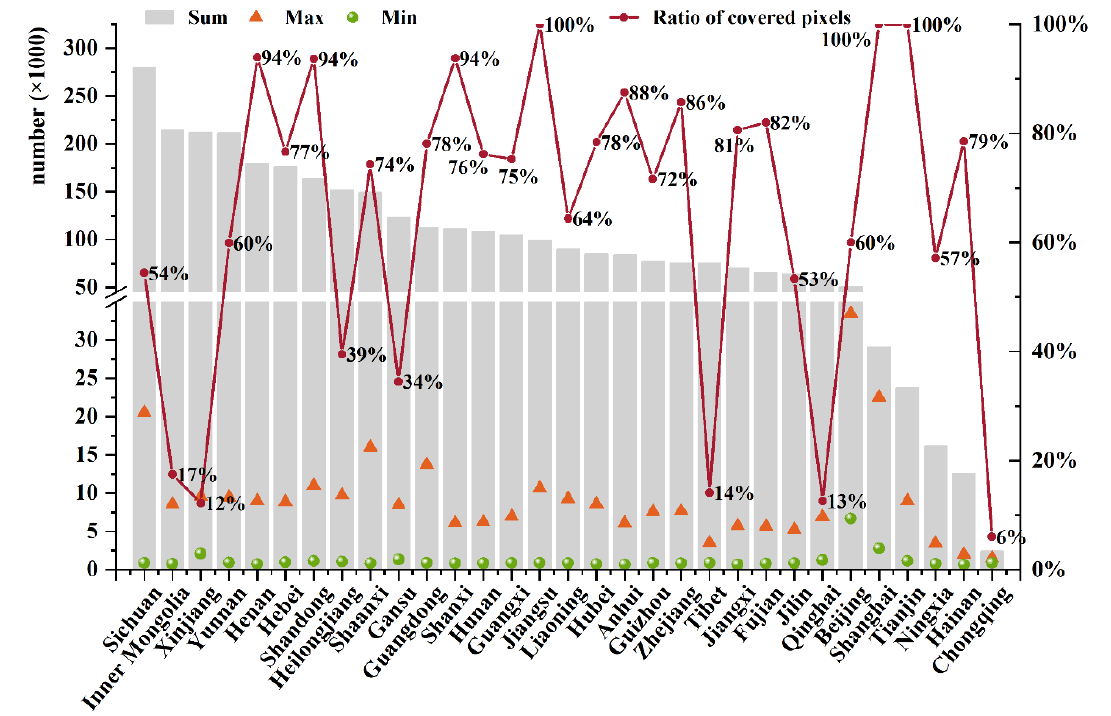
Figure 4. Summary of samples in each province and the ratio of covered pixels in the total area of each province.